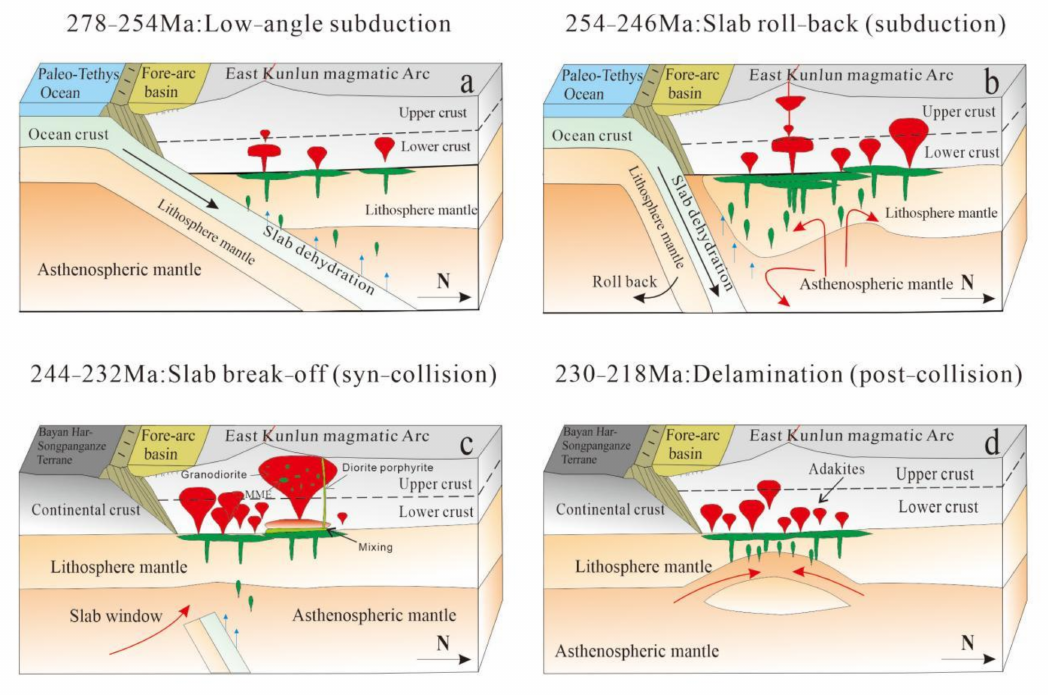
Figure 14. A schematic cartoon illustrating a proposed genetic model for geodynamic evolution in the eastern part of the East Kunlun Orogenic Belt. ( a ) Low-angle subduction; ( b ) slab roll-back; ( c ) slab break-off; ( d )